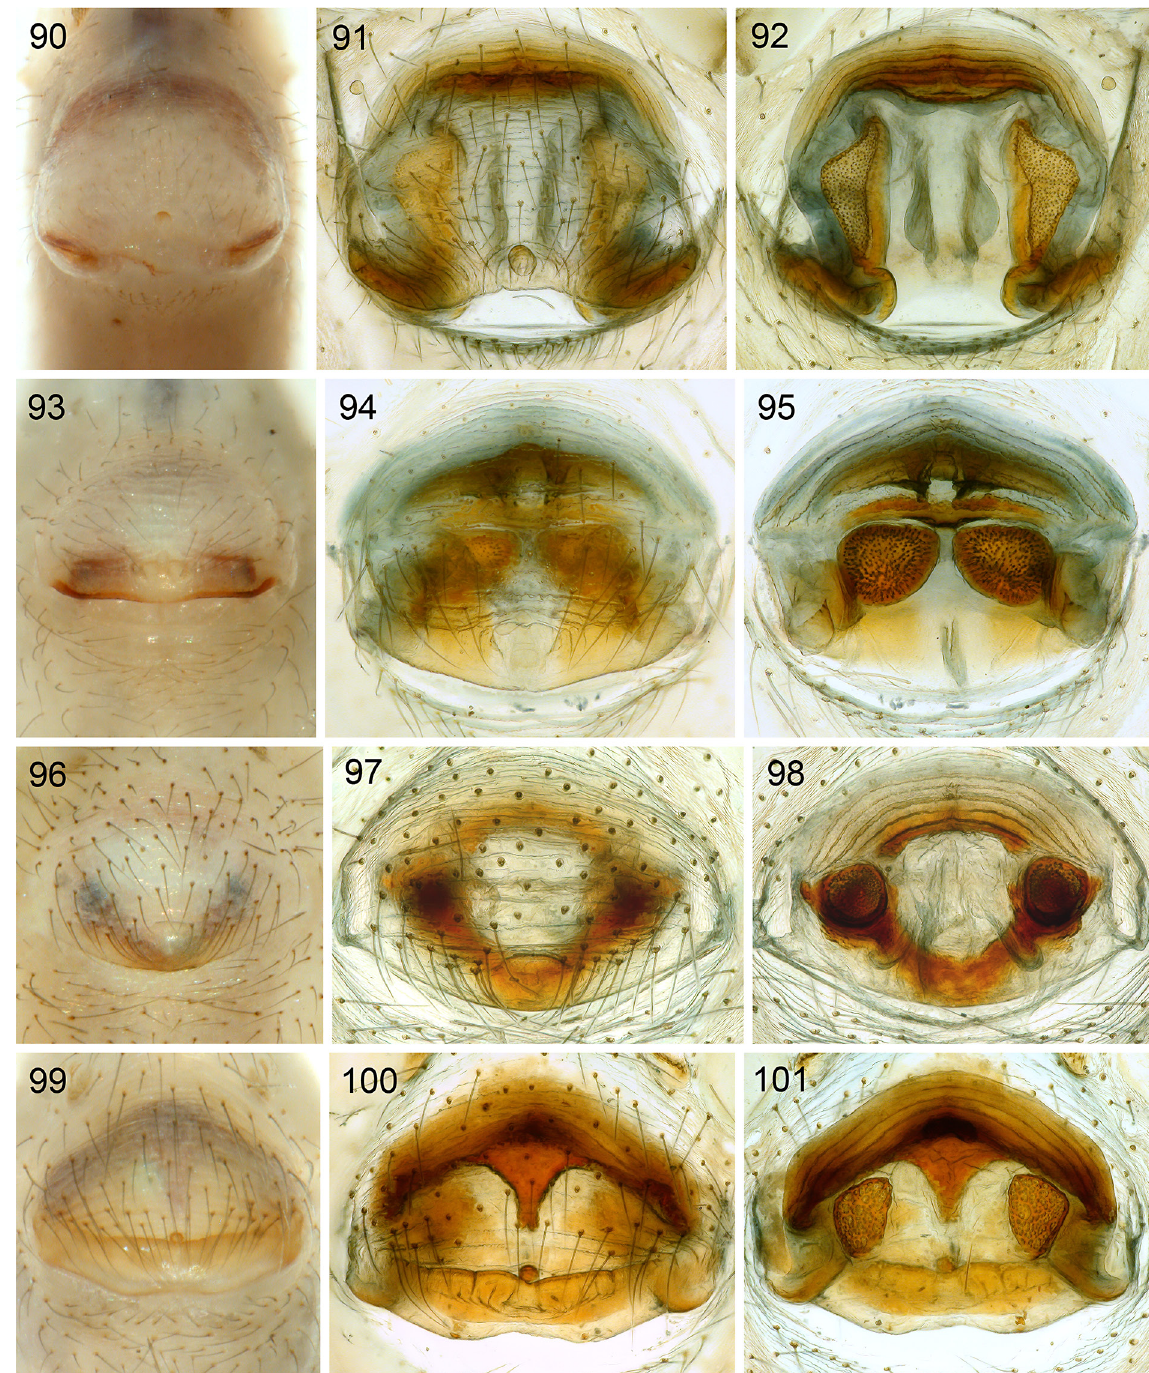
Figs 90–101. Female genitalia, untreated in ventral view, cleared in ventral and dorsal views. 90– 92 . Pholcus ubin Huber, sp. nov. 93–95 . Ph. lintang Huber, sp. nov. 96–98 . Ph. kuhapimuk Huber, sp. nov. 99–101 . Ph. khaolek Huber, sp.